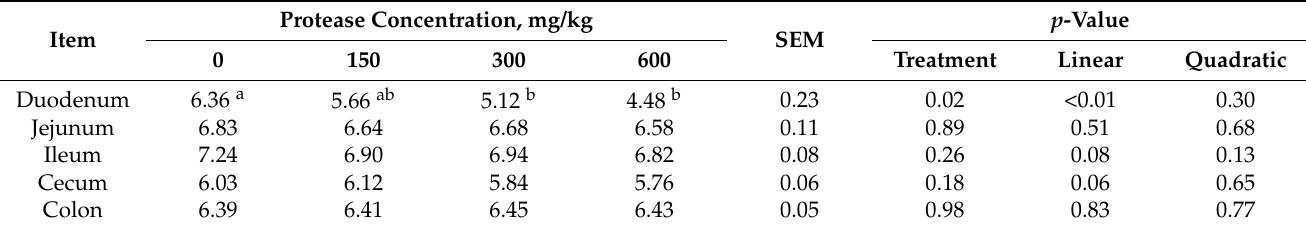
Table 9. Effects of protease supplementation on pH of intestinal chyme in weaned piglets.